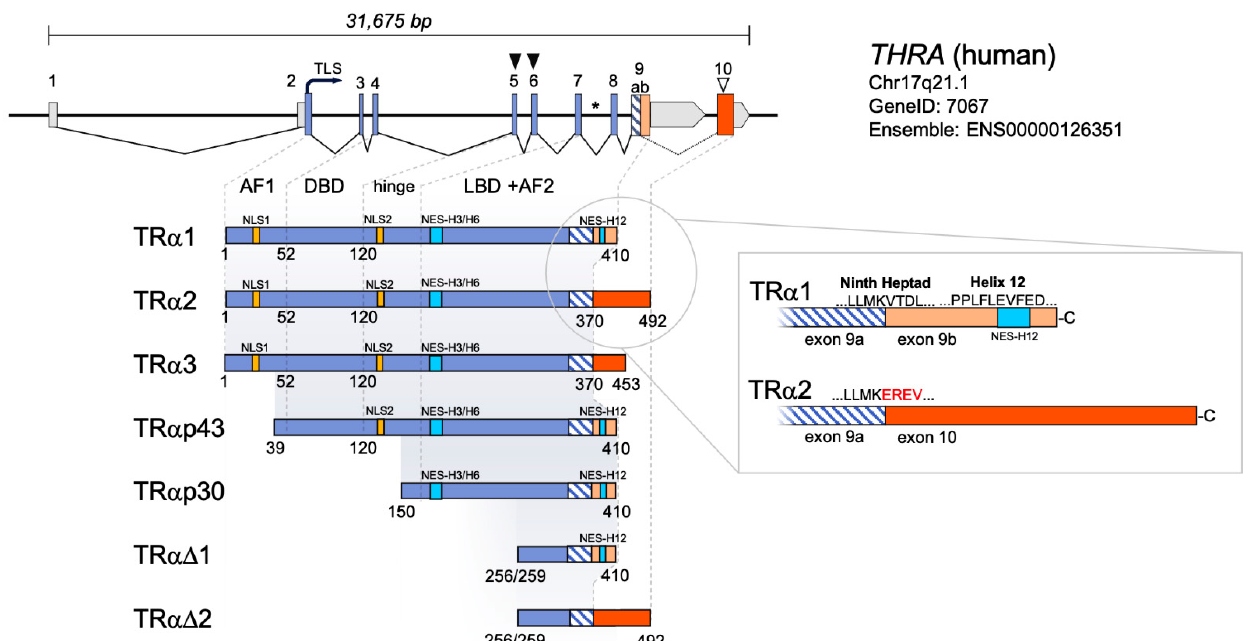
Figure 1. Genetic organization of THRA and domain structure of TR α isoforms. THRA consists of 10 exons encoding for a diverse set of TR α isoforms. Translation of TR α 1, TR α 2, and TR α 3 starts at a translational start site (TLS) in exon 2, whereas the use of two alternative TLS (closed triangles) results in generation of TR α p43 and TR α p30. TR α ∆ 1 and TR α ∆ 2 originate from alternative transcription at an internal transcriptional start site (asterisk) in intron 7. Generation of TR α 2 and TR α 3 also requires alternative splicing at an alternative splice site located in exon 9. The alternative splice acceptor for TR α 3 is located in exon 10 (open triangle). This results in several truncated isoforms lacking one to several domain structures such as the activator function 1 domain (AF1), the DNA-binding domain (DBD), the hinge region, parts of the ligand-binding domain (LBD), and the C-terminal AF2 domain. Intracellular localization is also affected by the different domain structures as loss of a certain domain also leads to loss of nuclear localization sequences (NLS; yellow boxes) and nuclear export sequences (NES; light blue boxes). The box displays a zoom in exon 9 and 10. An alternative splice site in exon 9 divides this exon into two parts (exon 9a and b), whereas splicing of exon 9a with exon 10 results in the formation of TR α 2, consequently disrupting the ninth heptad sequence as well as helix 12 and the NES-H12 in this